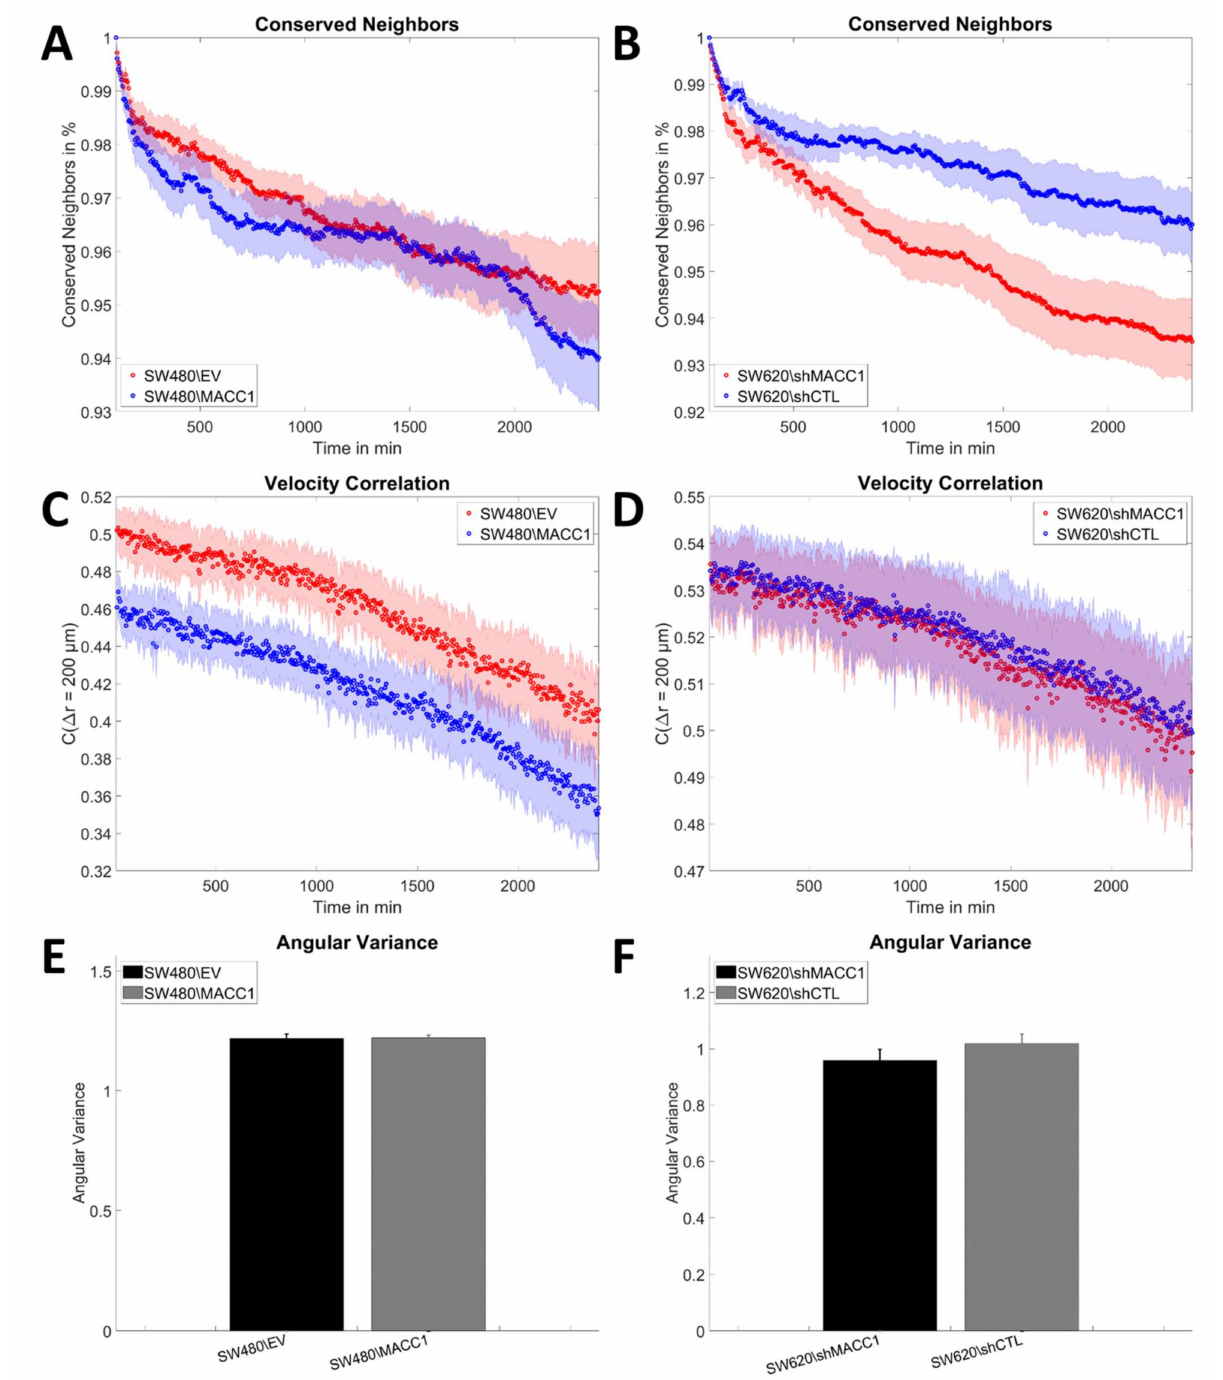
Figure A5. Reorganization and coordination in small cell clusters. ( A , B ) Illustration of the conserved neighborhood as a function of time. ( C , D ) Velocity auto-correlation at a distance of 200 µ m as a function of time. ( E , F ) Angular variance of the velocity field for both cell types. Error bars and shaded areas depict the standard error of the mean. Sample sizes: n SW480/EV = 14; n SW480/MACC1 = 14; n SW620/shMACC1 = 18; n SW620/shCTL =